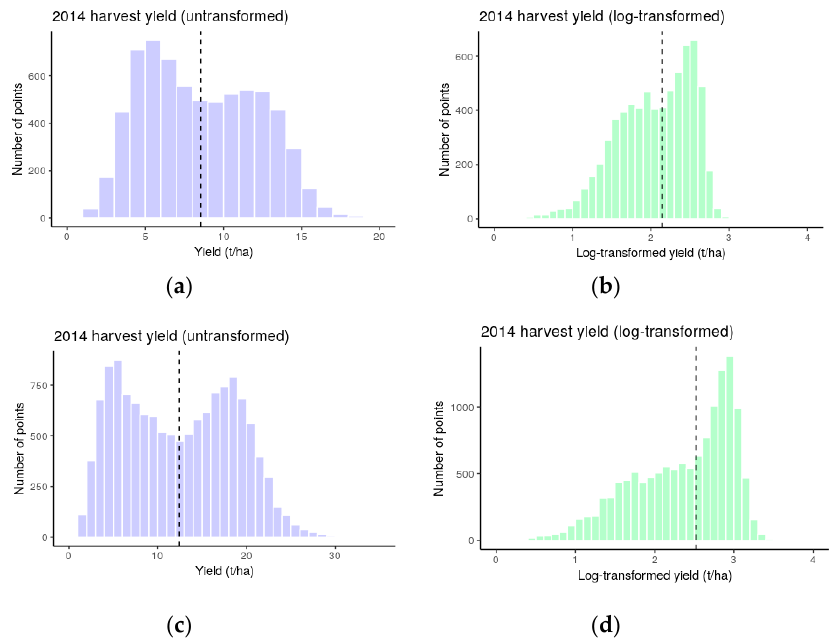
Figure 12. 2014 harvest yield data distribution (the vertical dash line represents the average value of the data distribution): ( a ) untransformed (site 1); ( b ) log-transformed (site 1); ( c ) untransformed (site 2); ( d ) log-transformed (site 2).